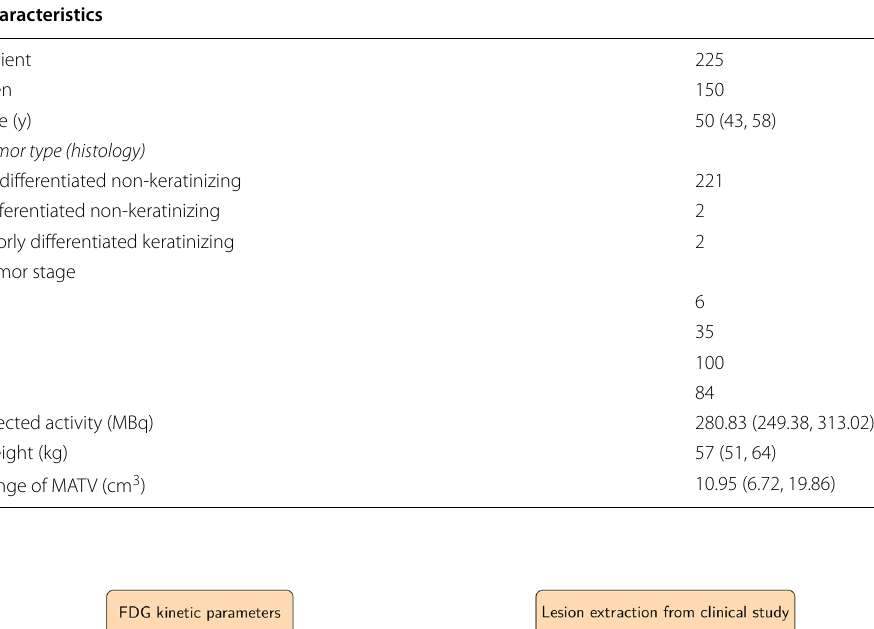
Table 1 Patient characteristics (n